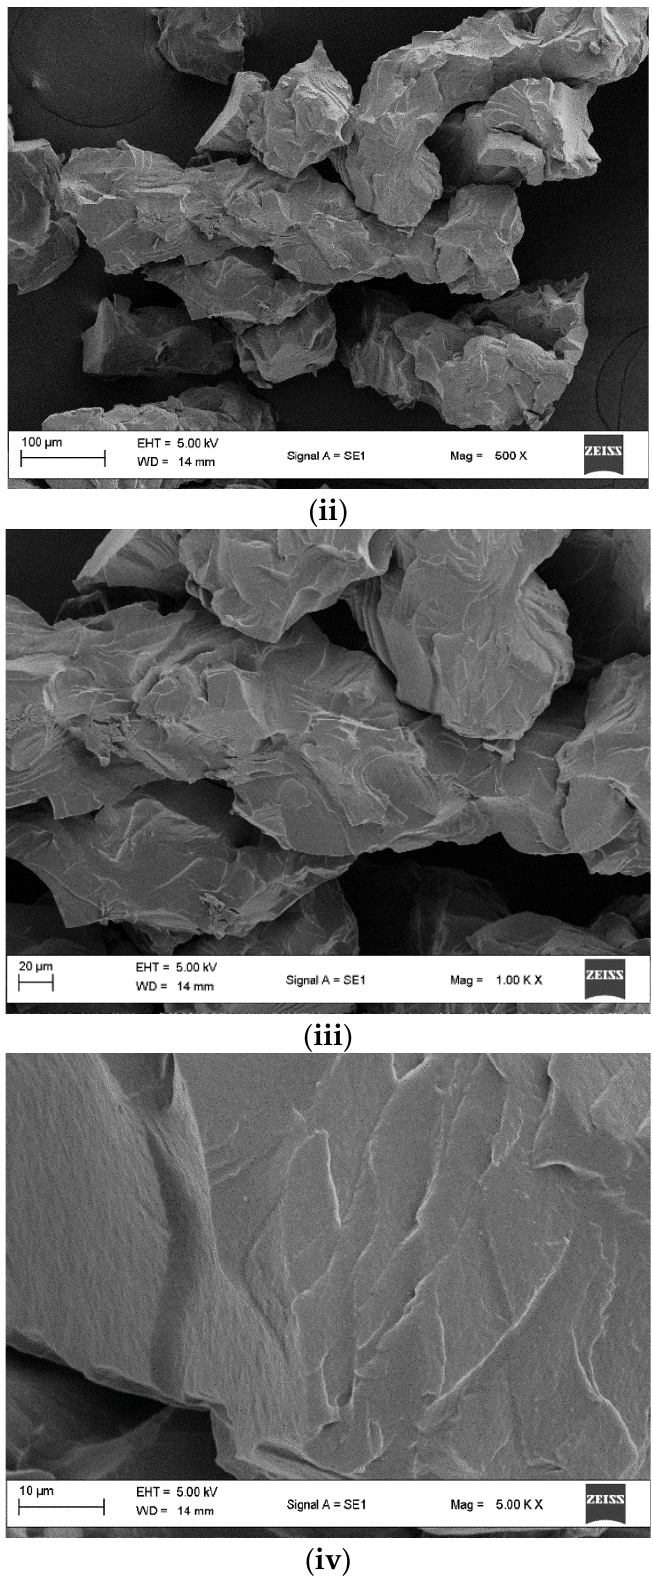
Figure 3. SEM images of amino-Li-resins after SPPS using shaking and gravity filtration: ( i ) 200 µm; ( ii ) 100 µm; ( iii ) 20 µm; and ( iv ) 10 µm.